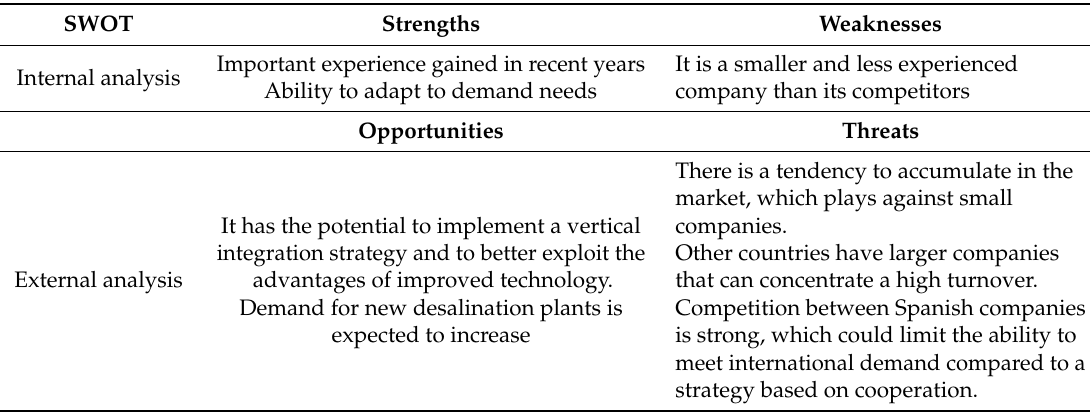
Table 1. SWOT analysis for the company